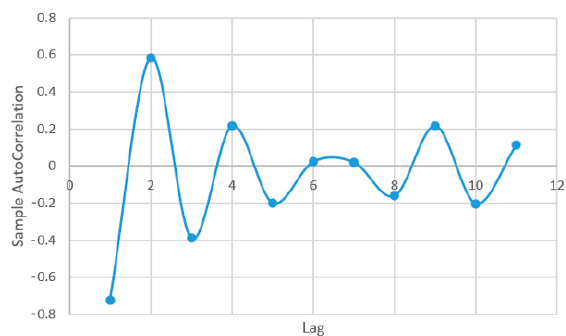
Figure A9. The AC with transformation in square roots—BH series.